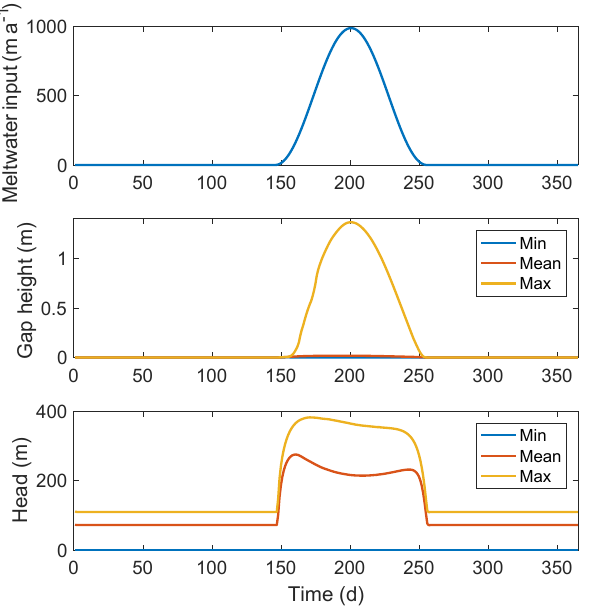
Figure 5. Seasonal cycle of distributed meltwater input over one annual cycle, with gap height and head evolution time series. As meltwater input increases, the maximum gap height increases, then decreases simultaneously with the decrease in input. As meltwa- ter input increases, the head increases, then decreases as efficient drainage pathways are established (corresponding to lower water pressure in the efficient pathways and lower head in the unchannel- ized upstream regions as shown in Fig. 6). As melt decreases, mean head increases again as the efficient pathways start to collapse, then decreases as melt returns to the winter